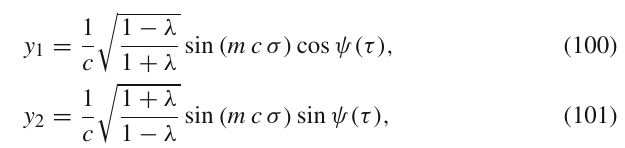
Fig. 2 Indicative translationally invariant solutions of the SL ( 2 , R )/ U ( 1 ) V model. The left panel corresponds to a rotating solution, while the right one to an oscillating solution. Notice that as